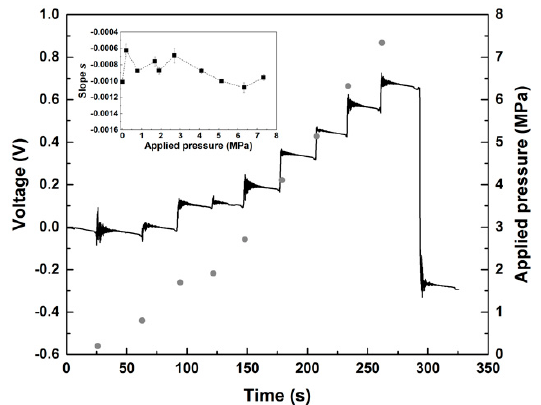
Figure 4. Time evolution of the output voltage V(t) (solid line) of the PS 1 sensor during the ramping up of pressure (circles) in the calibration pump. The inset displays the pressure dependence of the slope s for the PS 1.